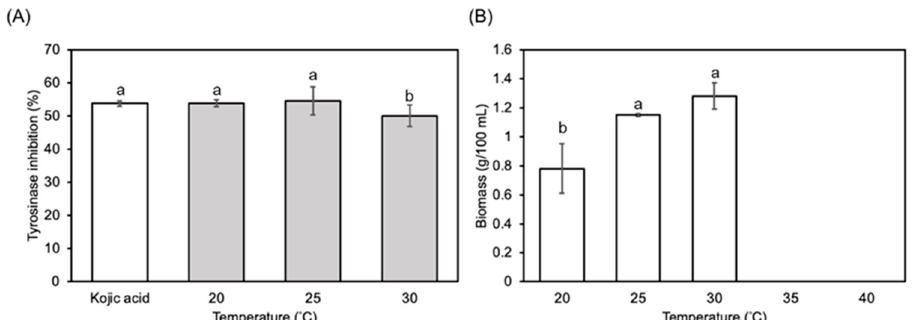
Table 1. Mycelia yield and tyrosinase inhibition rate after using the optimized culture conditions. Figure 2. Culture medium supplied with different carbon sources for Ganoderma formosanum sub- Group * merged fermentation. ( A ) Tyrosinase inhibition activity of G. formosanum extracts (GFE; 1 mg/mL) Control (basal medium) obtained from medium containing glucose, fructose, lactose, and sucrose (20–80 g/L). Kojic acid (0.25 mg/mL) was used as the positive control. ( B ) Biomass of GF-EPS obtained from different carbon sources. Means with different letters indicate that they are significantly different ( p < 0.05).